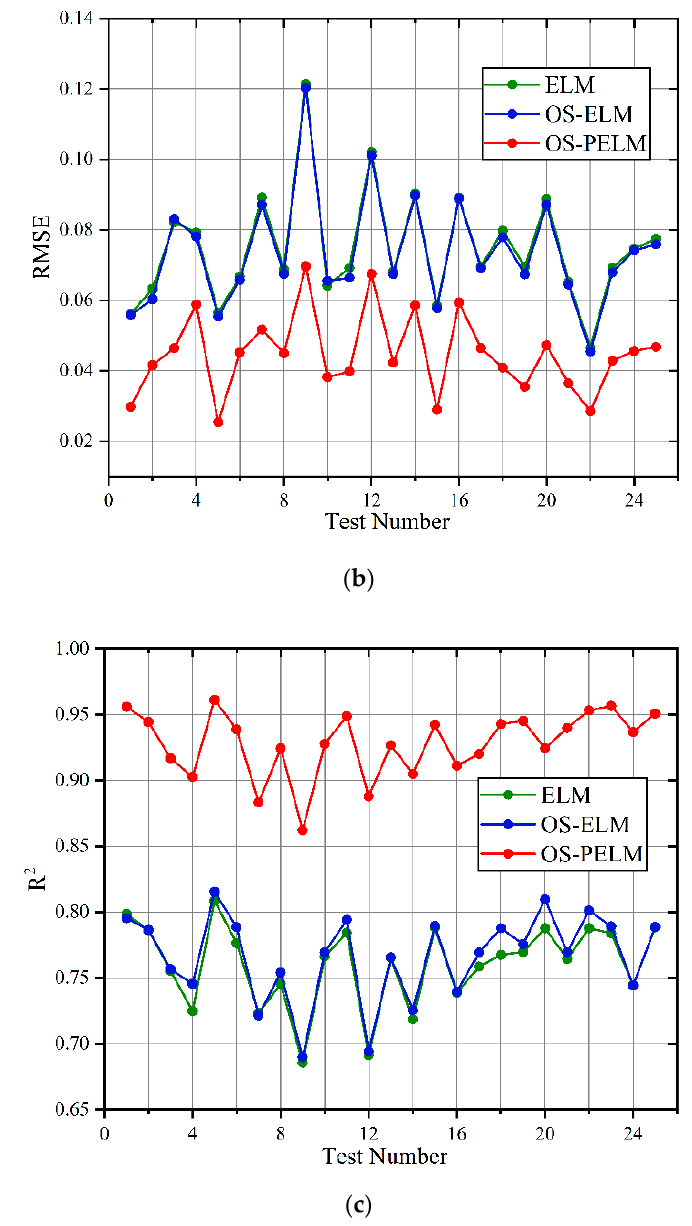
Figure 13. Prediction error evaluation of the three models. ( a ) is the MAE of the three models, ( b ) is the RMSE of the three models, and ( c ) is the R 2 of the three models. Table 3. Predictive performances of MC